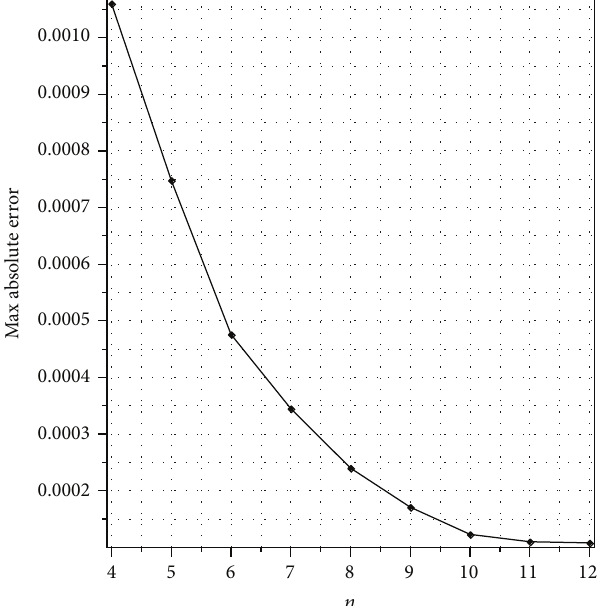
Figure 4: Plot of the maximum absolute errors for different values of 𝑛 with 𝑡 = 0.75 and 𝑘 = 8 for Example 2.